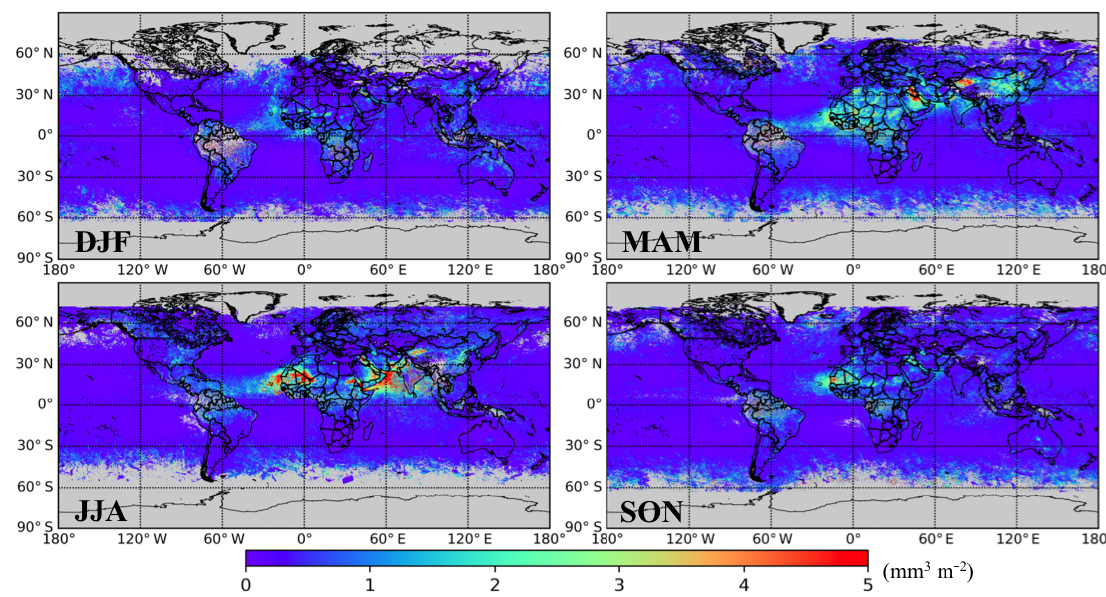
Figure 20. Same as Fig. 16, but for coarse-mode absorbing insoluble (CAI, FeO x , and carbonaceous